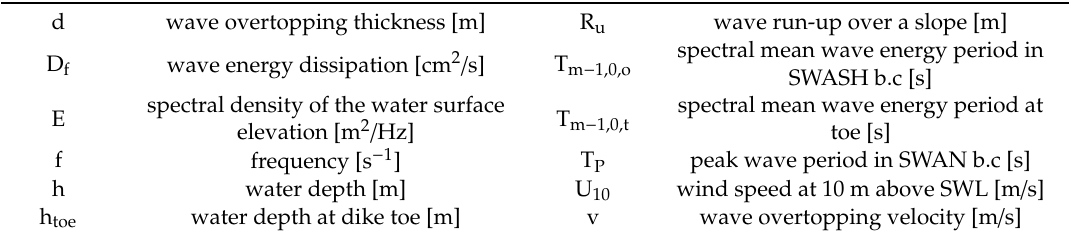
Table 1. Nomenclature used in this